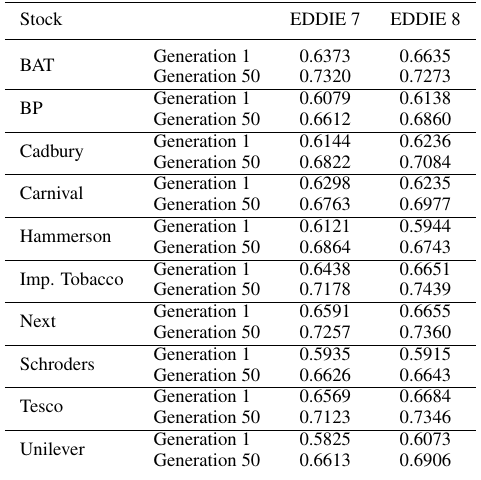
Table 4 Average Best Fit at generation 1 and 50, for EDDIE 7 and EDDIE 8, over the 10 stocks. Each stock has 4 values, 2 for EDDIE 7 and 2 for EDDIE 8. The top value represents the average Best Fit at generation 1, and the bottom value represents the average Best Fit at generation 50.